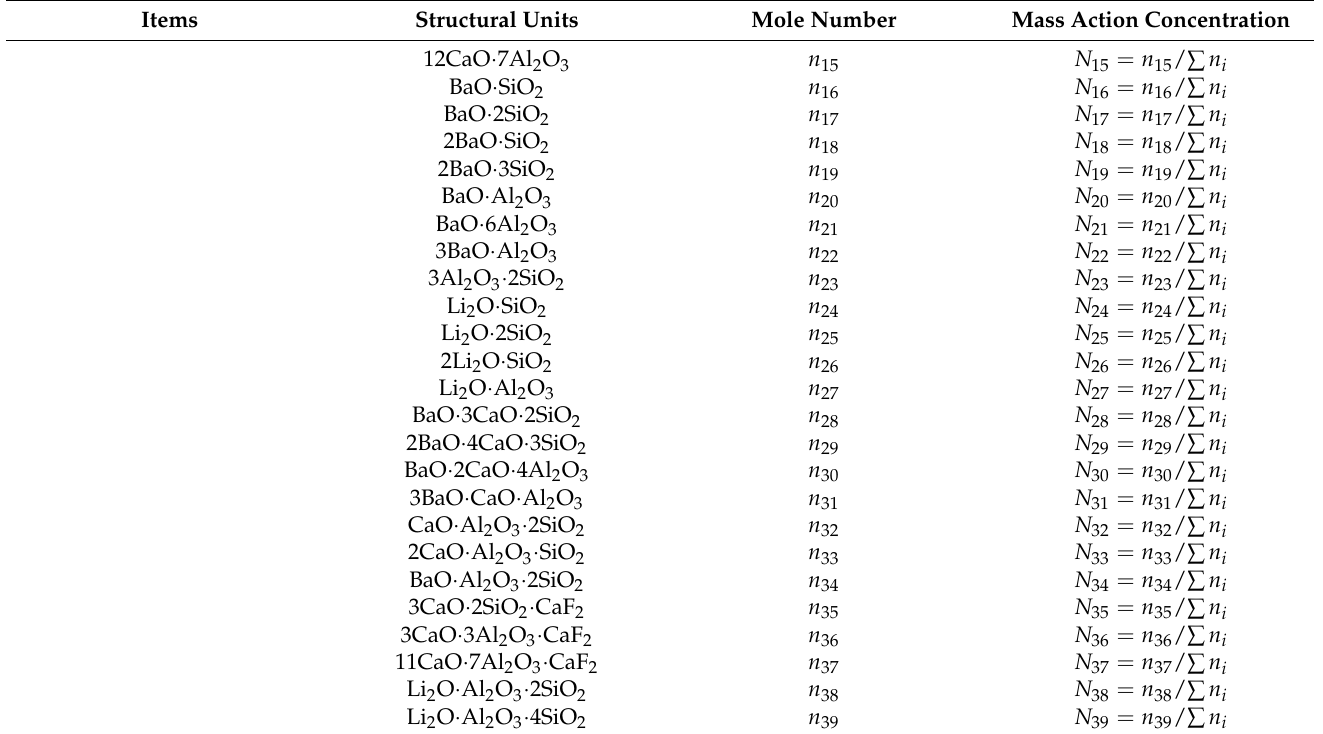
Structural Units Mole Number Mass Action